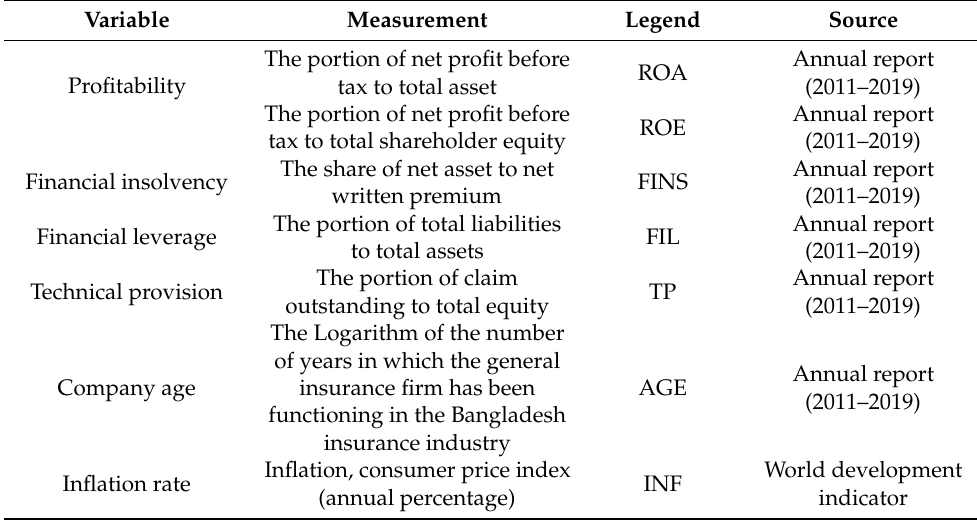
Table 2. List of employed variables, measurements, and their sources.